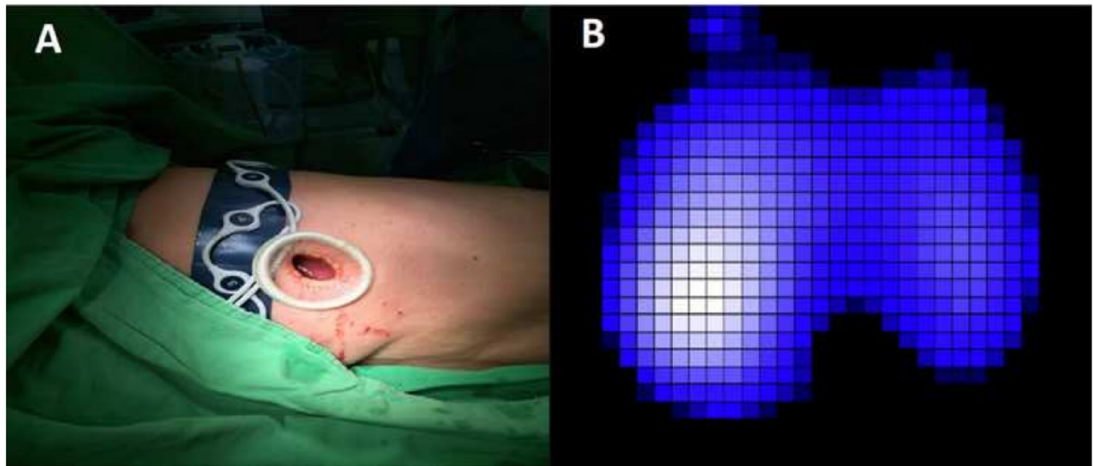
Figure 1. ( A ): The patient is placed in the right lateral position. The belt is applied to the third intercostal region. A uniportal VATS wound is made just below the EIT belt. ( B ): For left-sided NITS, the ventilation distribution at Ev.2 revealed better ventilation in the dependent lung (66.2% on the right vs. 33.8% on the left).